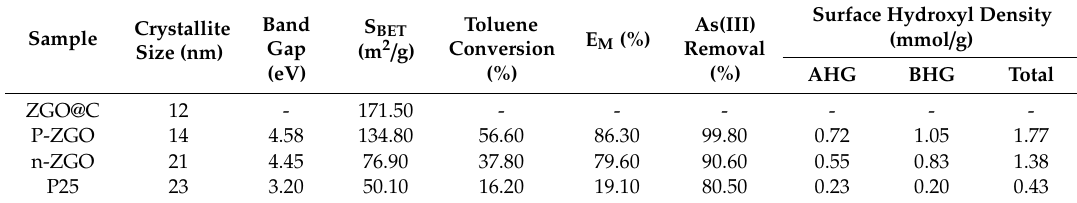
Figure 3. The SEM and TEM images of the ( a – c ) n-ZGO, ( d , e ) ZGO@C and ( g – i ) P-ZGO samples with different magnifications, and ( f ) shows the TG/DTA curves of the ZGO@C sample in flowing air.